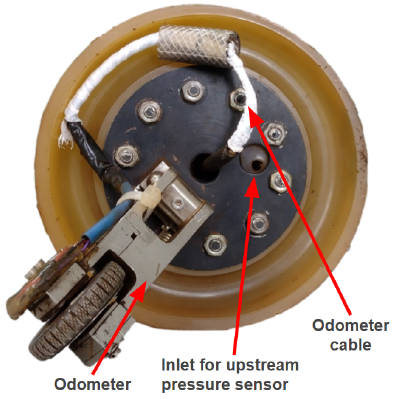
Figure 18. Front and rear views of Prototype PIG 2. Rear